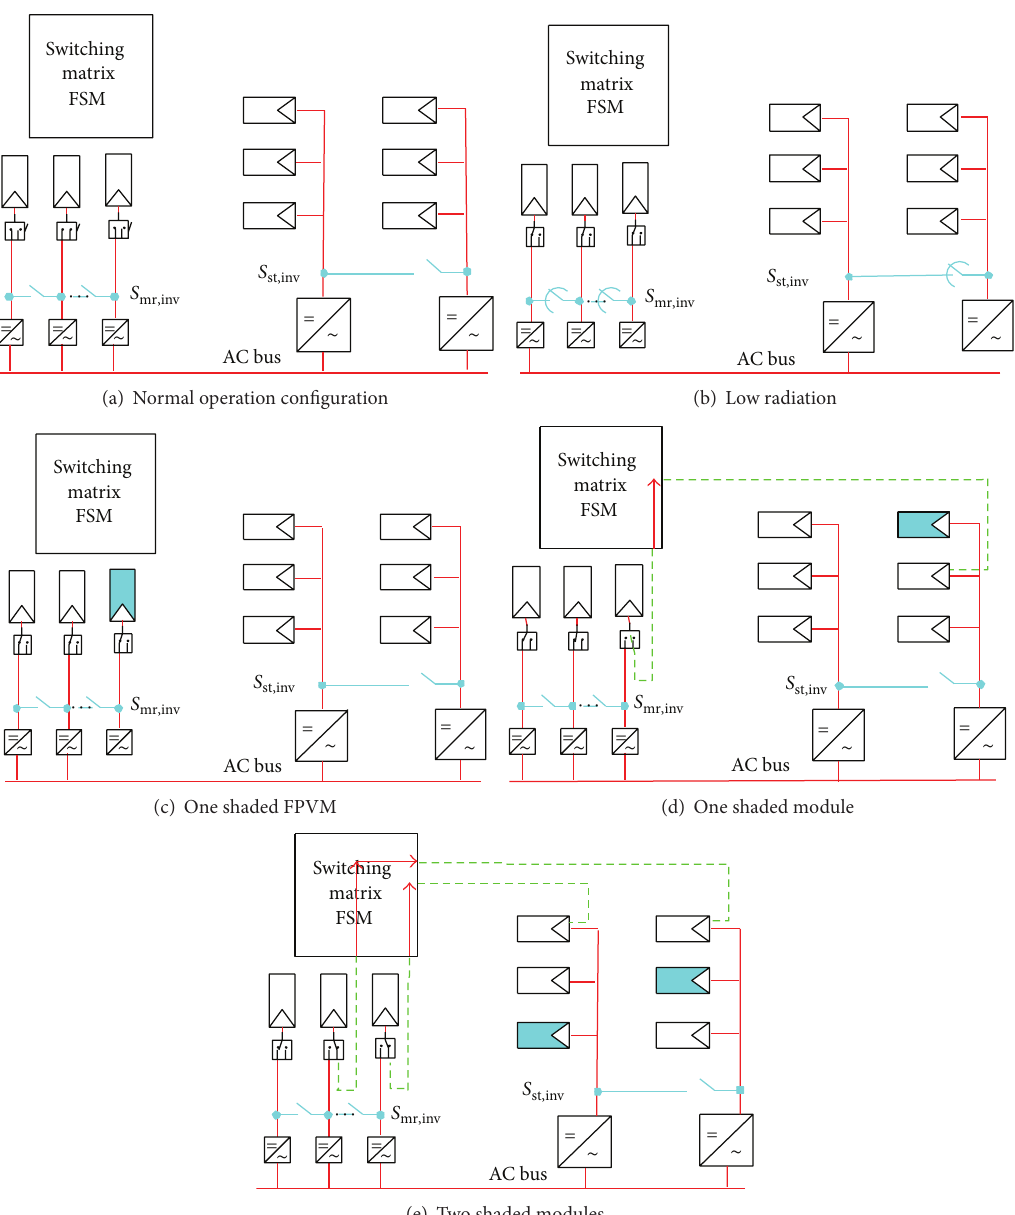
Figure 2: The adaptive PV string-inverter configuration under differing operating